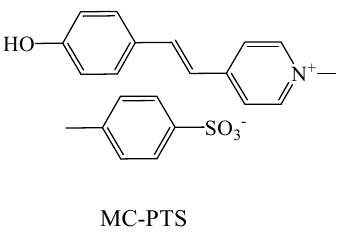
Figure 5. Molecular structure of 1-methyl-4(2-(4-hydroxyphenyl)vinyl) pyridinium 4-toluenesufonate (MC-PTS).